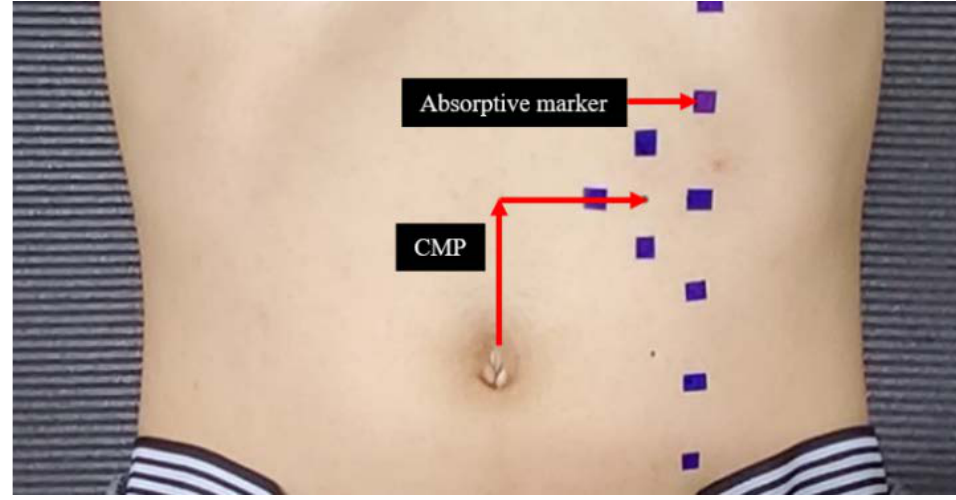
Figure 2. Center of measurement position (CMP) and absorptive markers.